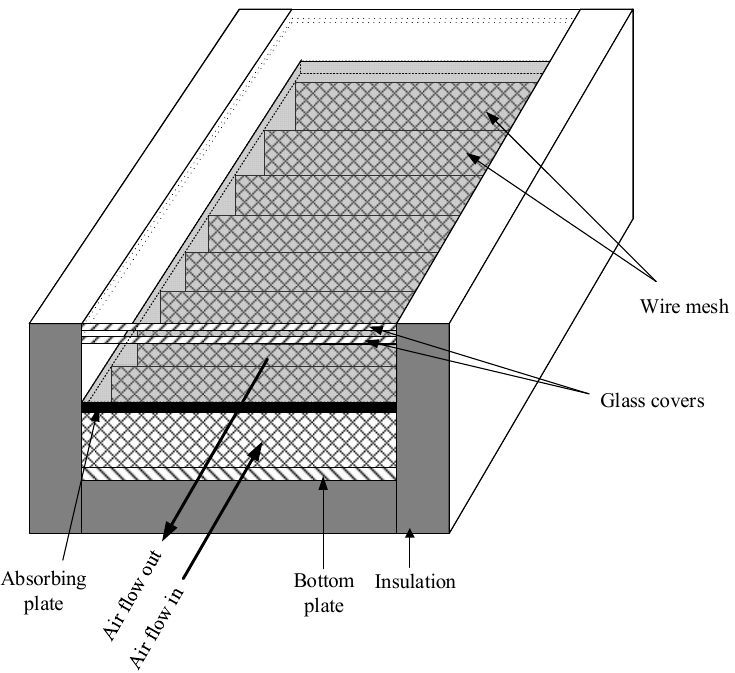
Figure 1. Configuration of a recycling double-pass solar air heater.